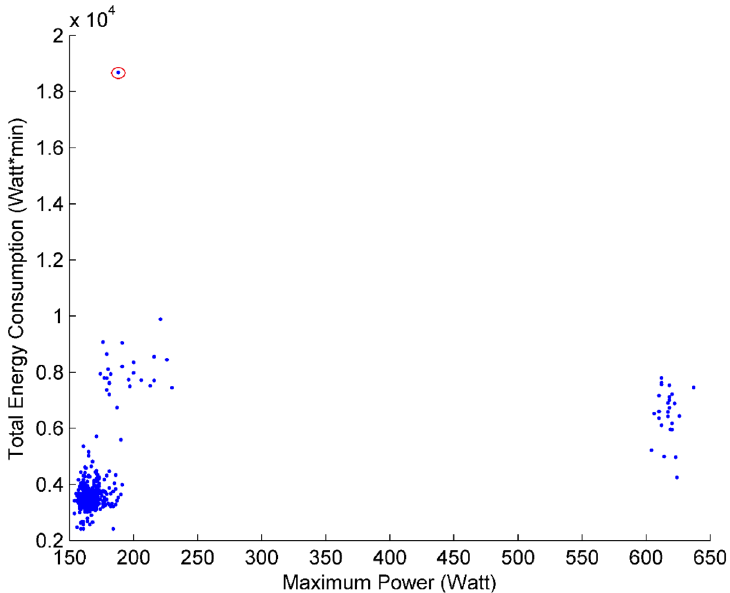
Figure 5. Distribution for cycles start between 1:00 to 6:59.